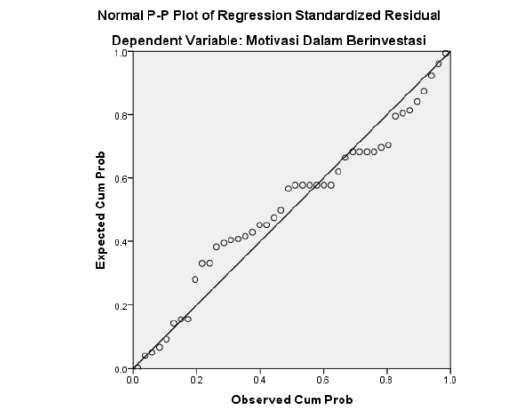
Figure 1 : Normality Test Results; Source: Processed data, 2022